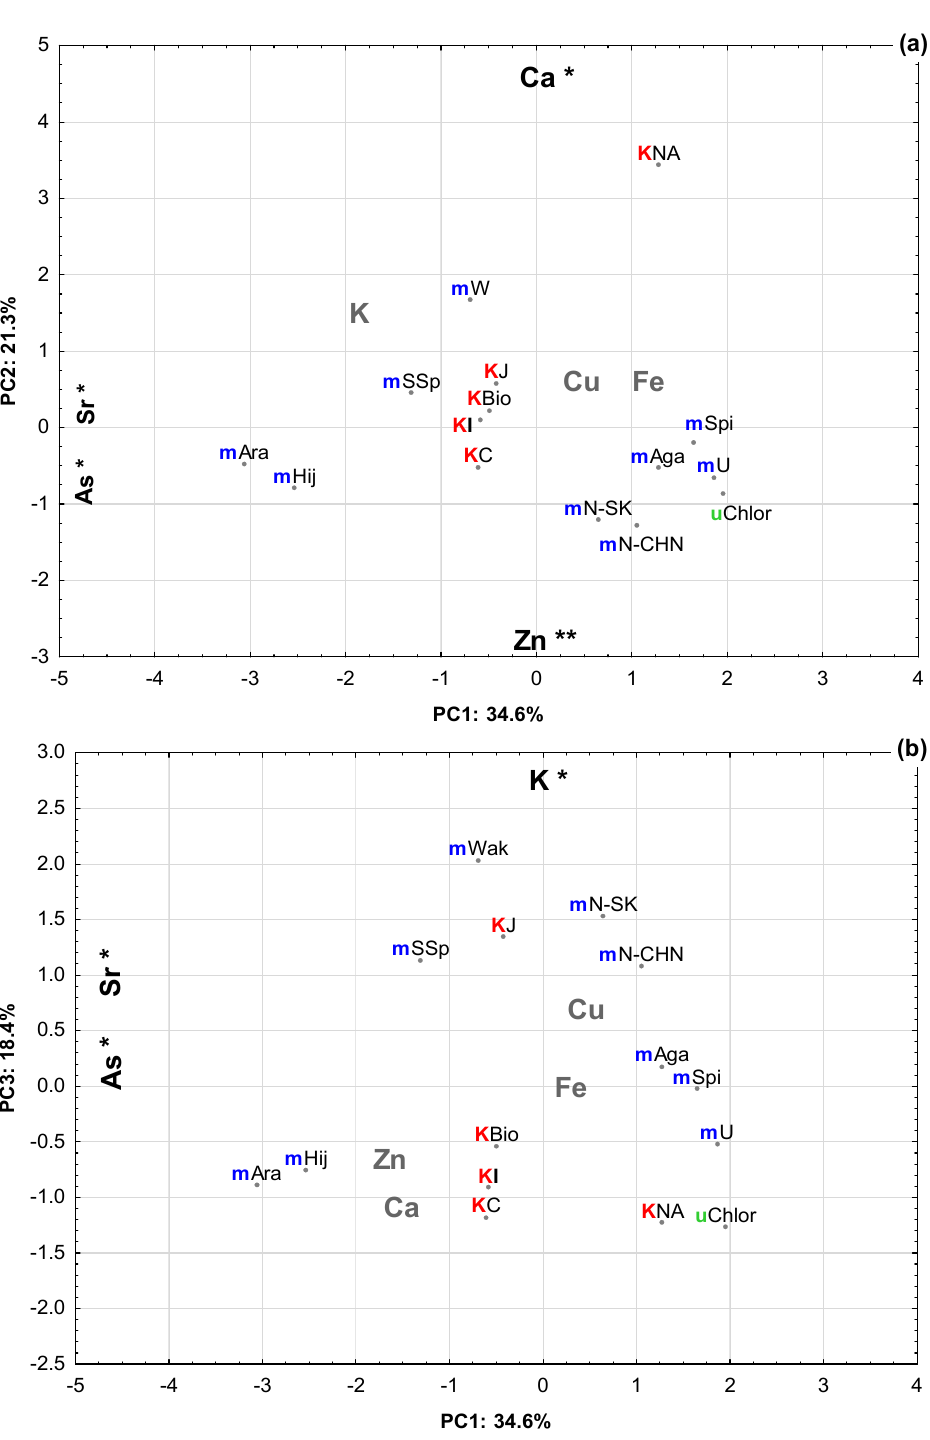
Figure 1. Principal component analysis projection of samples: ( a ) PC1 vs. PC2 and ( b ) PC1 vs. PC3. The most important variables for the definition of the two components are shown in each axis, indicating the direction in which each element grows. KC, KBio, KI, KNA and KJ, represents samples of Kelps from different origins. The designation different multicellular organisms are abbreviated (example mHij refers to Hijiki) and uChlor refers to unicellular Chlorella . ** moderately significant correlation values between the element and the PC; * strongly significant correlation values between the element and the PC.